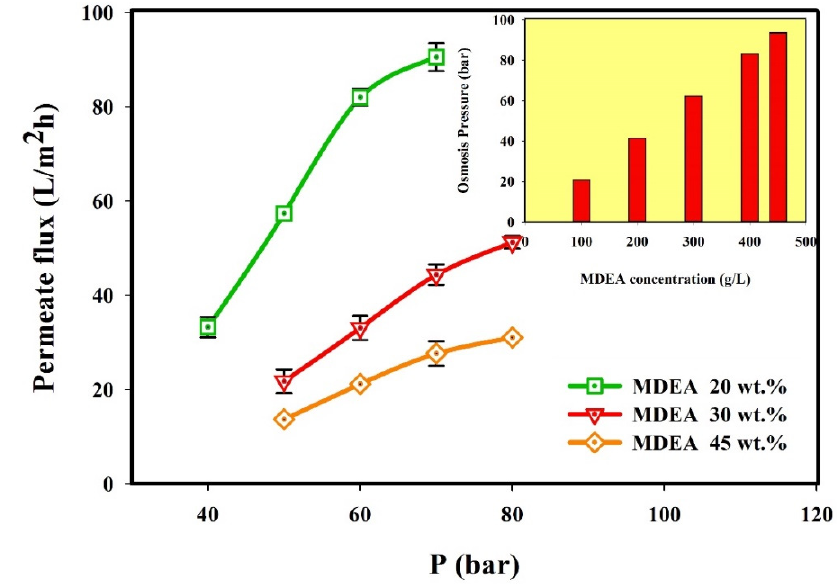
Figure 2. The e ff ect of pressure on permeate flux for 20–45 wt.% MDEA solution in the presence of Figure 2. The effect of pressure on permeate flux for 20–45 wt. % MDEA solution in the presence of multi-component mixtures of ions by NF-3 membrane at 0.693 L / h, 35 ◦ C and pH = 10; Insert: Osmotic multi-component mixtures of ions by NF-3 membrane at 0.693 L/h, 35 °C and pH = 10; Insert: Osmotic pressure as a function of MDEA pressure as a function of MDEA concentration.